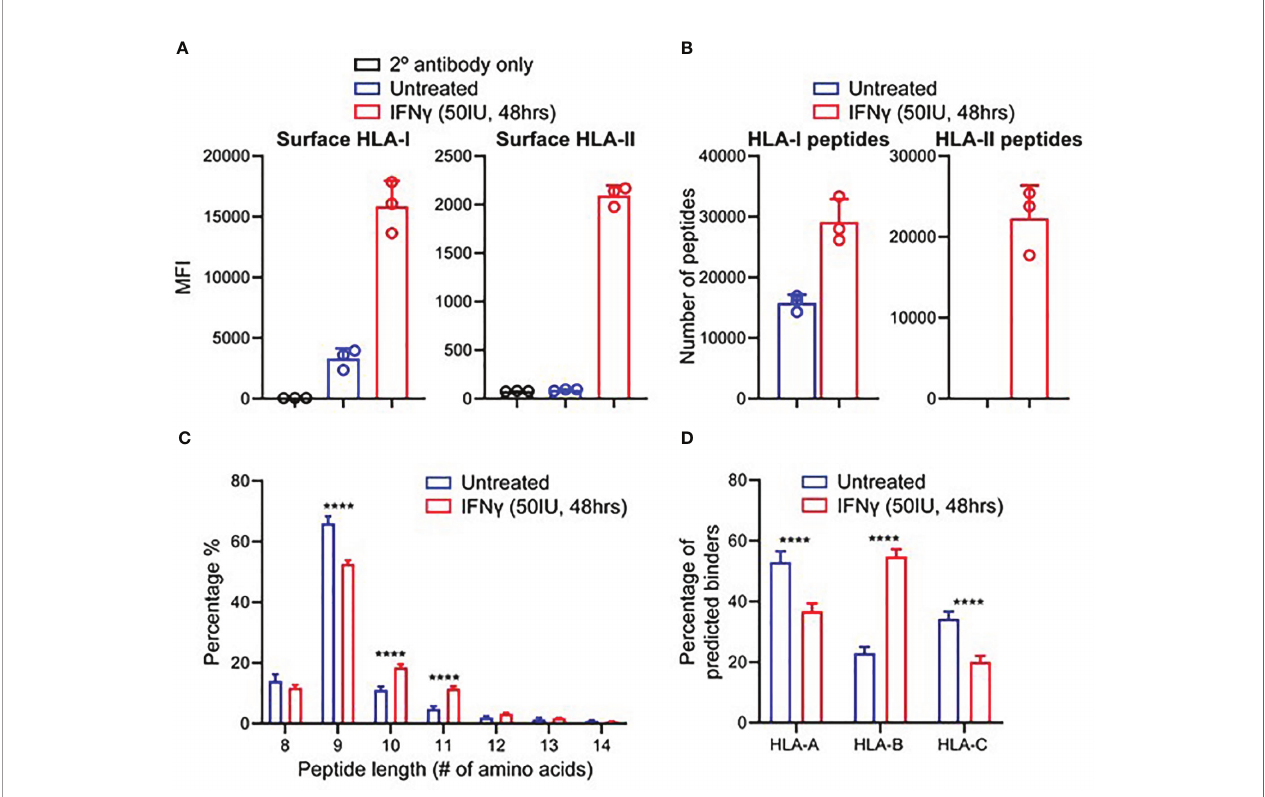
FIGURE 1 | IFN g modulates HLA expression and the immunopeptidome of MDA-MB-231 cells. (A) Flow cytometry staining of HLA class I and class II expression following IFN g stimulation. Median fl uorescence intensity (MFI) is shown across three biological replicates (mean ± SD). (B) Immunopeptidome pro fi ling of MDA-MB- 231 cells in the presence or absence of IFN g , showing number of peptides for HLA-I and HLA-II. (C) Length analysis of unique HLA-I peptides derived from MDA- MB-231 cells with and without IFN g treatment. (D) NetMHCpan 4.0 HLA-A, -B, and -C binding prediction of each unique 8 – 12 mer peptide from IFN g treated and untreated replicates. Statistical analysis was performed by using a two-way ANOVA and signi fi cance is denoted by ****(P < 0.001). All data are from three biological replicates per